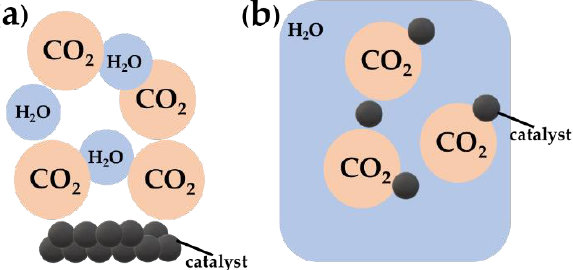
Figure 9. Schematics of gas-solid ( a ) and liquid-solid ( b ) systems for photocatalytic CO 2 reduction. In a gas-solid system, the H 2 O molecule is present as water vapor and the catalyst is uniformly dispersed at the bottom of the reactor or uniformly coated on the substrate and placed at the bottom of the reactor. CO 2 gas flows into the reactor as a continuous stream or exists in the closed off-line system as a saturated gas. Zhang et al. [101] found that if TiO 2 nanotubes supported by Pt were used as photocatalyst, methane production in- creased when the concentration of water around the catalyst and the surface –OH group was relatively high. However, when Pt–TiO 2 nanoparticles were used as catalyst, the CO 2 /H 2 O ratio had no effect on methane production. This indicates that the adsorption energy of water molecules on the catalyst surface affects the activity of the gas-phase pho- tocatalytic system. Due to the microporous structure and surface properties of the mate- rials, the adsorption of CO 2 and H 2 O on the active sites leads to different photocatalytic processes and the formation of different products [102]. In a liquid-solid system, the catalyst is suspended in an aqueous solution. Before the reaction, CO 2 gas is bubbled into the water to reach the saturation state [103]. The yield of product when using H 2 O as reducing agent is very low. It was found that adding trieth- anolamine or isopropanol into the solution consumes holes to improve the efficiency of photocatalytic CO 2 reduction. Kaneco et al. [104] used TiO 2 to photocatalytically reduce CO 2 in isopropanol solution. The CO 2 was reduced to methane, and isopropanol was oxi- dized to acetone. Another factor with a great influence on the reaction system is the sus- pension pH. Alkaline substances (NaOH, NaHCO 3 , etc.) are usually added to the solution